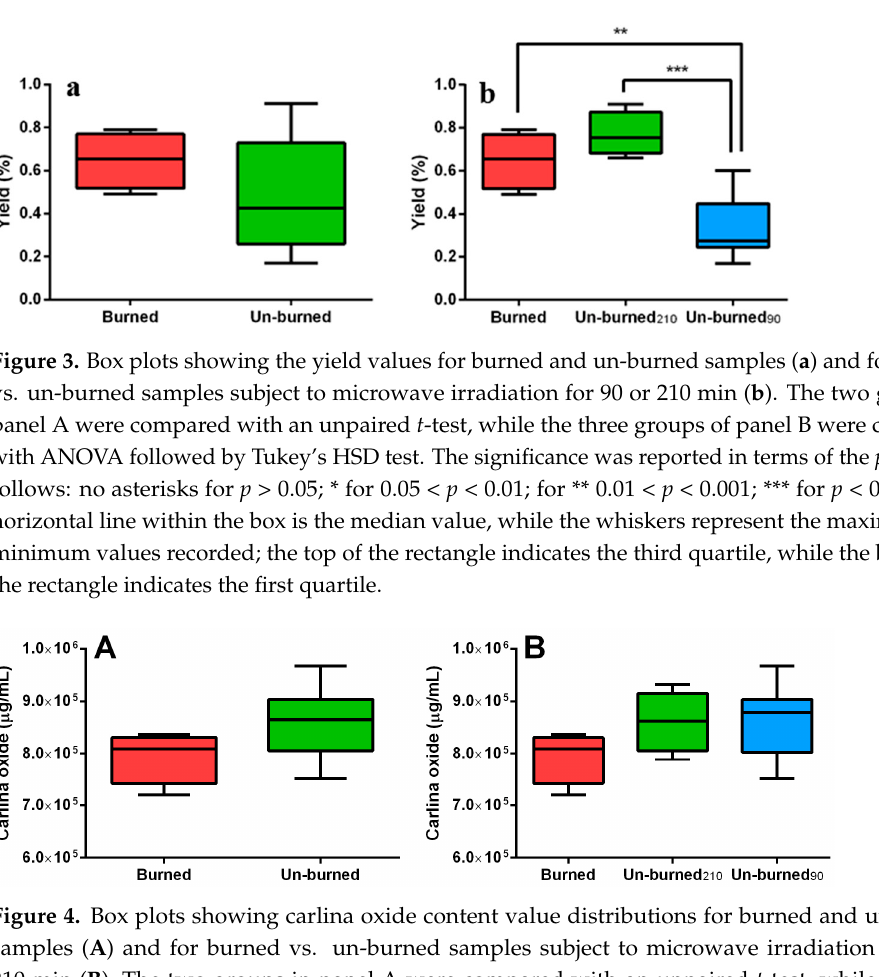
Figure 5. Influence of the extraction time on essential oil (EO) yield (%) and carlina oxide content (µg/mL) for the extraction runs performed after the fractional factorial design (FFD) (Section S1 of the Supplementary Materials). Results of different extraction time points for both responses were matched with ANOVA and further analyzed using Tukey’s HSD test for significant differences. Different letters show significant differences (Tukey’s HSD test, p < 0.05).